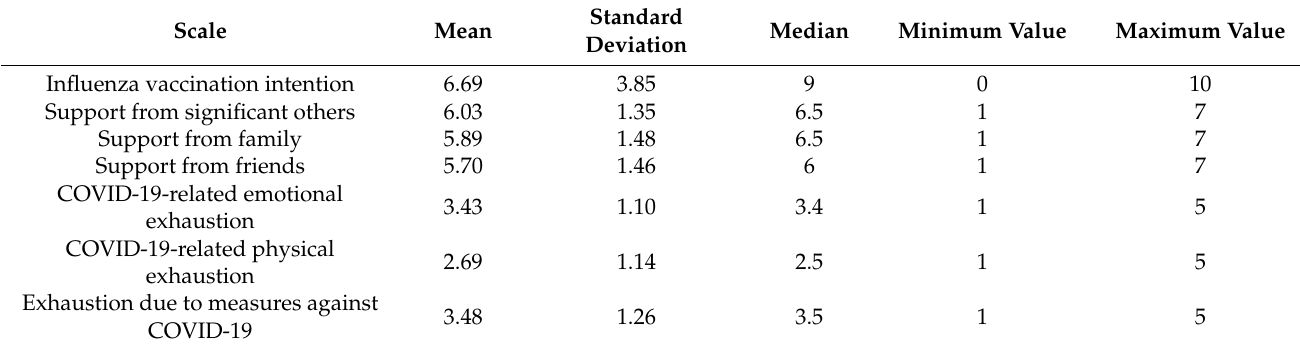
Table 2. Descriptive statistics for the scales in this